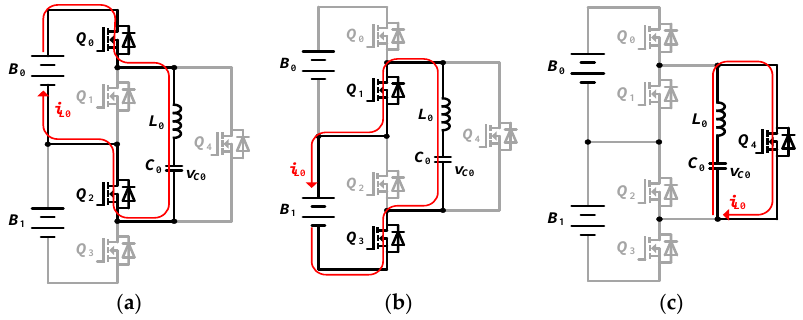
Figure 3. Operating states of the proposed equalizer at V B 0 > V B 1 . ( a ) charge state S 1 ; ( b ) discharge state S 2 ; ( c ) release state S 3 .